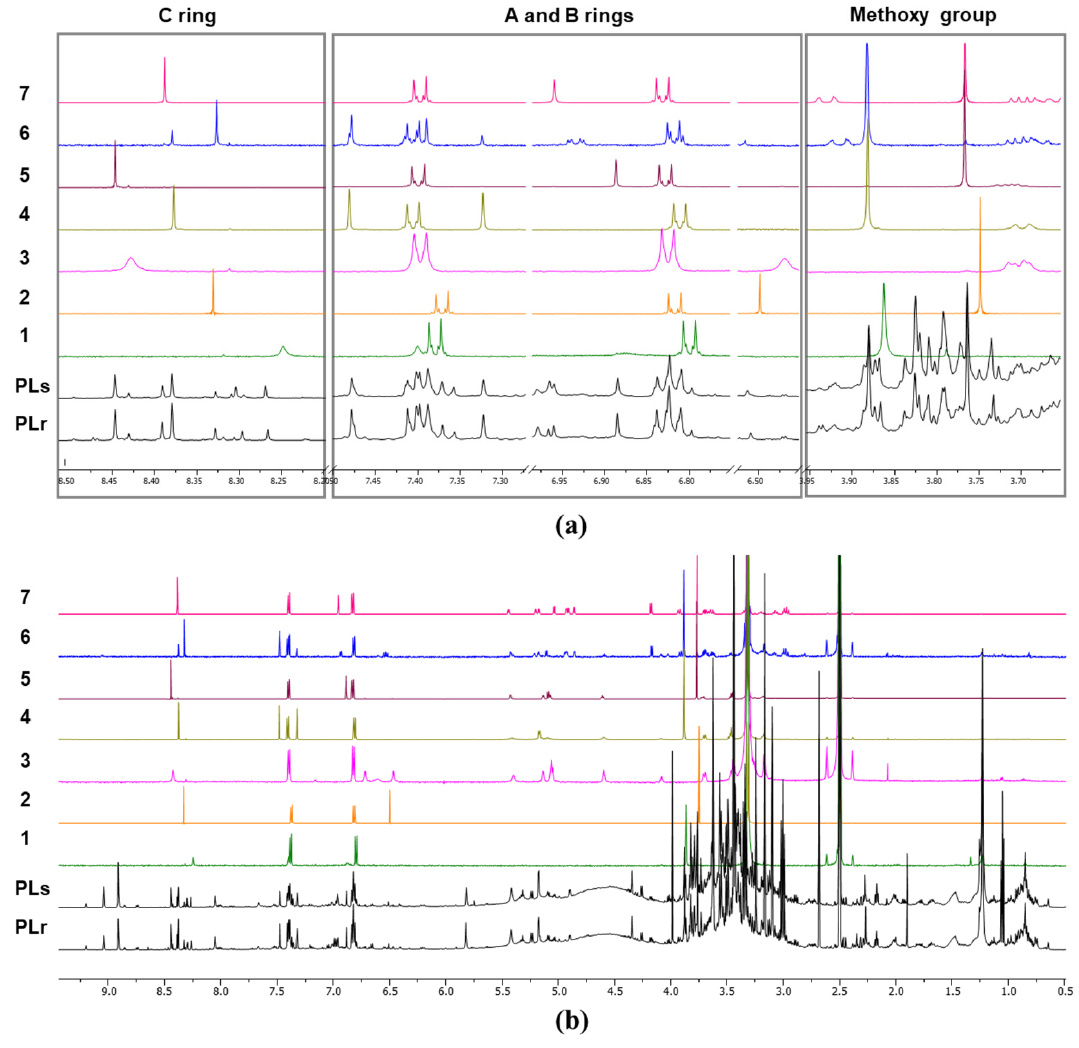
Figure 2. qHNMR spectra of PLs (MeOH sonication), PLr (MeOH reflux) extracts, and seven major isoflavones 1 – 7: ( a ) expanded and ( b ) full qHNMR spectra.